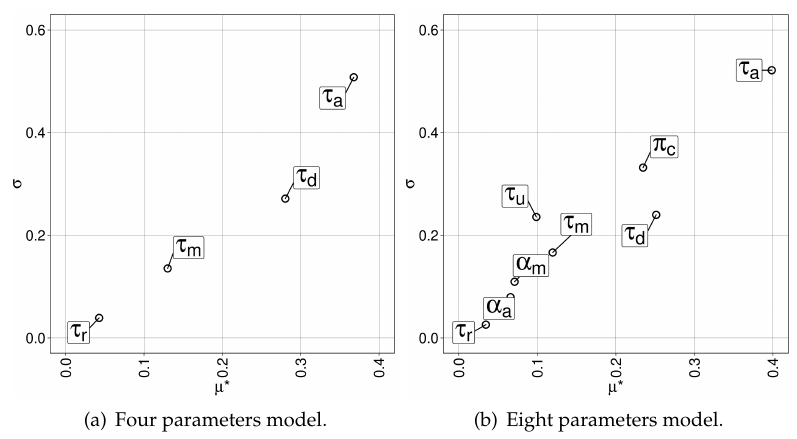
Figure 5. Parameter sensitivity study ( σ and µ (cid:63) ) for the model using four and eight parameters to modify the behaviour and performance of